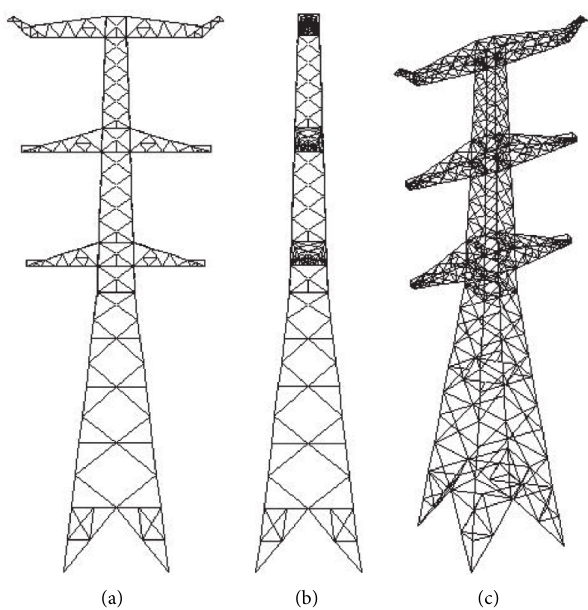
Figure 7: Finite element model of the transmission line tower: (a) X - Z plane; (b) Y - Z plane; (c) X - Y - Z space.